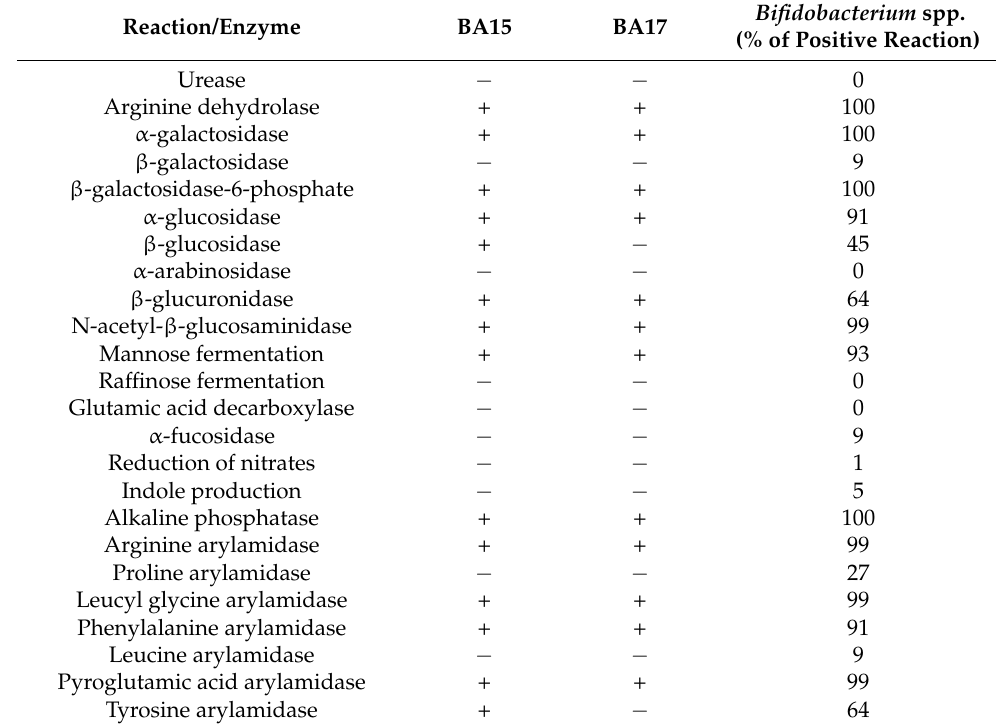
Table 2. Enzymatic profile exhibited by the Bifidobacterium asteroides BA15 and BA17 strains. Reaction/Enzyme BA15 BA17